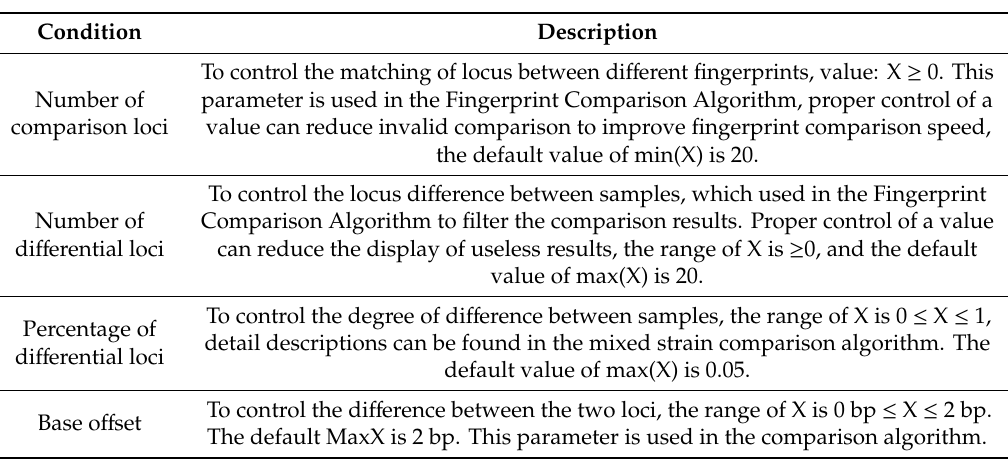
Table 2. Parameters required in the Fingerprint Comparison